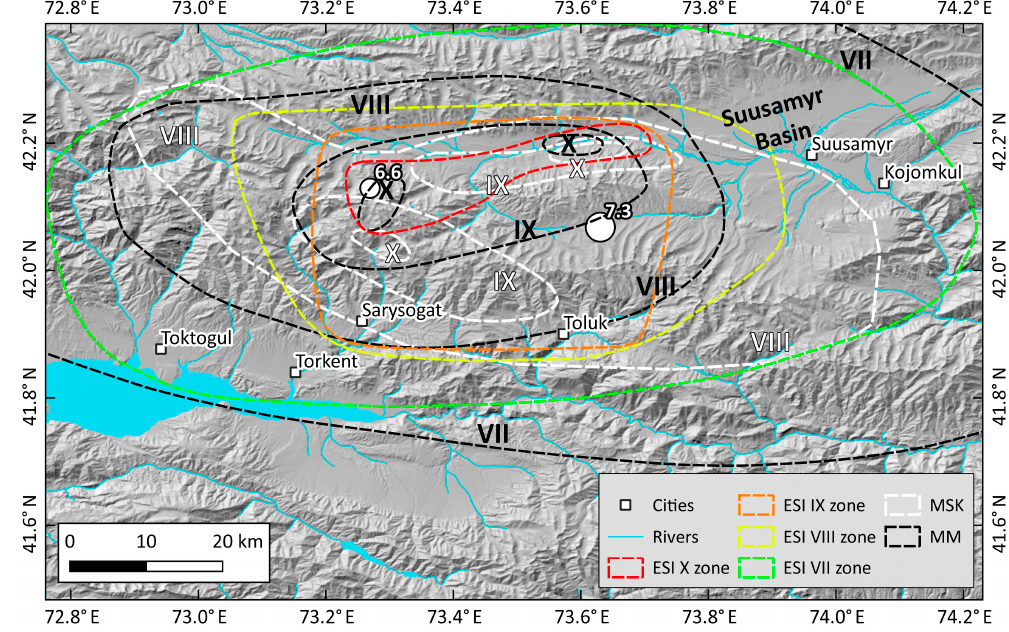
Figure 6. Comparison of ESI2007 intensities with MM isoseismals [6] and MSK intensities from Reference [19]. Note the shift to the south of the ESI = IX, which we attribute to the sparse population in the high mountains of the Aramsu range, which hampers traditional MM and MSK intensity assessments.